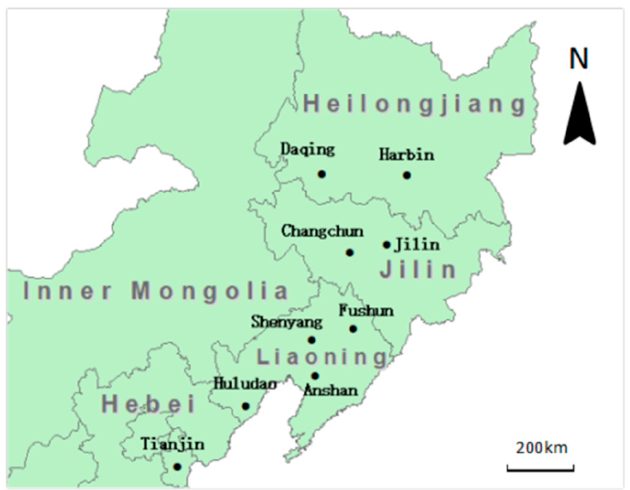
Figure 1. Nine sampling cities for whole air VOCs samples collected in Northeast Region of China in July